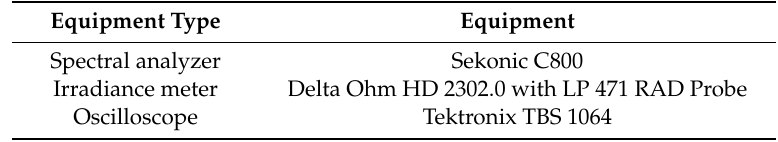
Table 5. Equipment used during the tests.